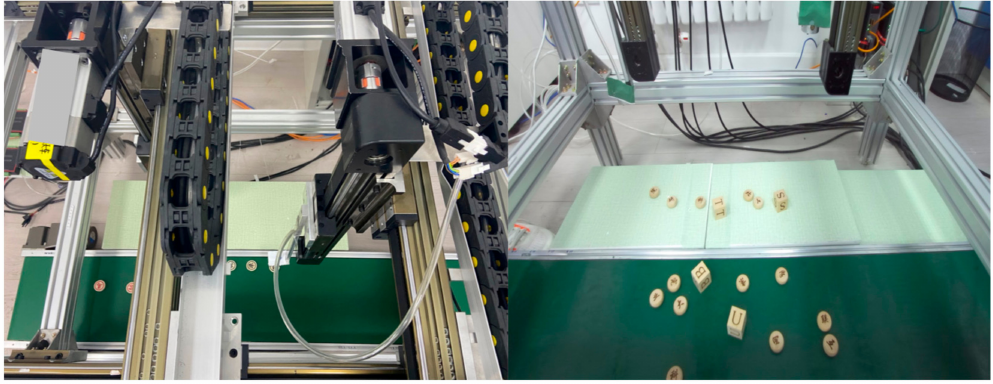
Figure 9. The experimental diagram of the crane visual sorting